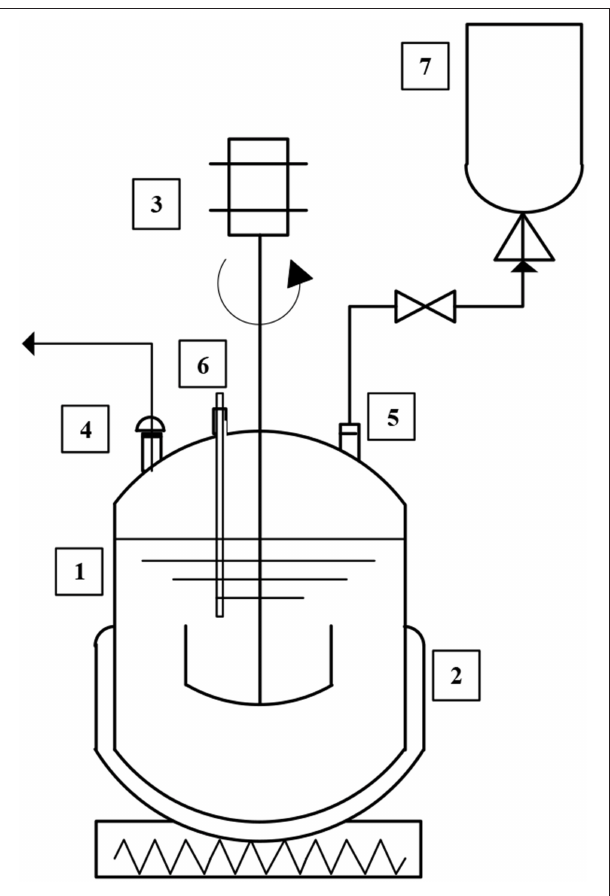
FIGURE 1 | Schematic diagram of the laboratory-scale anaerobic digestion system. (1) Reactor, (2) heating jacket, (3) motor agitation, (4) sampling port, (5) biogas port, (6) temperature probe, and (7) Tedlar ®